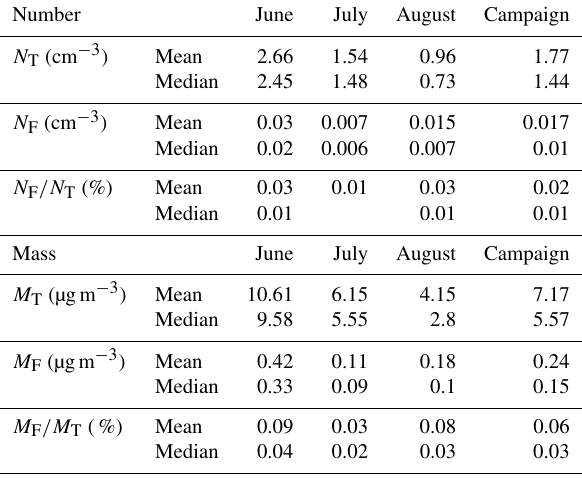
Table 2. Integrated number concentrations and mass concentrations of coarse TAP and FBAP ( ∼ 1–20µm): arithmetic mean and median for each month and for the entire measurement